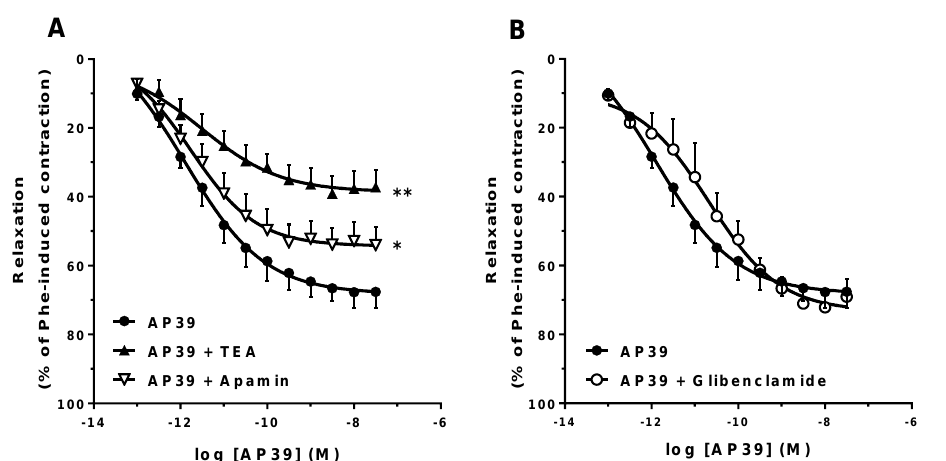
Figure 4. Participation of K + channels in the AP39-induced vasorelaxation of mouse mesenteric artery rings precontracted with Phe. The responses were evaluated in the presence of the nonselective K + channel blocker TEA (3 mM) or the selective SK Ca channel blocker apamin (5 µ M; panel ( A ); n = 7/group). Panel ( B ) shows the AP39 responses in the presence of the K ATP channel blocker glibenclamide (10 µ M; n = 5/group). Data are expressed as mean ± S.E.M. E max differences were observed (* p < 0.05 or ** p < 0.01 vs. AP39 alone) as analyzed by the Student’s t -test. Table 1. Summary of the AP39 concentration–response curve parameters obtained from the AP39- induced vasorelaxation of mouse mesenteric artery rings under control conditions and in the presence of the different enzyme inhibitors and channel blockers tested (shown in Figures 2–4). * p < 0.05; ** p < 0.01 vs. intact rings with no additions (E+).